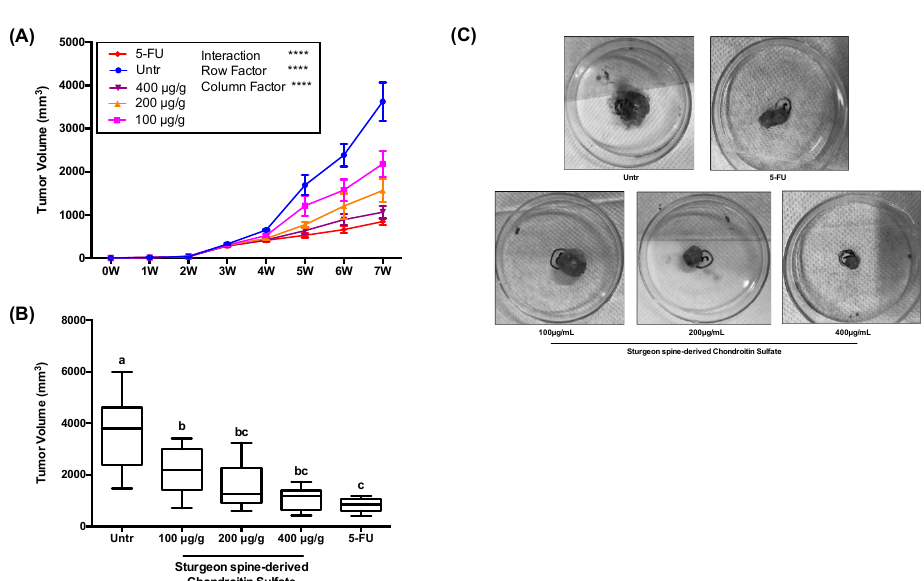
Figure 5. E ff ect of SCS on tumor volume in HCT-116 xenograft tumor mice model. During the 7-week experiment, the tumor volume of each animal was measured every week and the final tumor volume was measured after sacrifice. ( A ) Tumor volume in each time point, **** indicates p < 0.0001 as compared to every other group, ( B ) final tumor volume, ( C ) representation images of tumors from each group. All results are expressed as mean ± SEM ( n = 10). Different superscript letters for each column indicate significant differences ( p < 0.05) as compared to every other group.